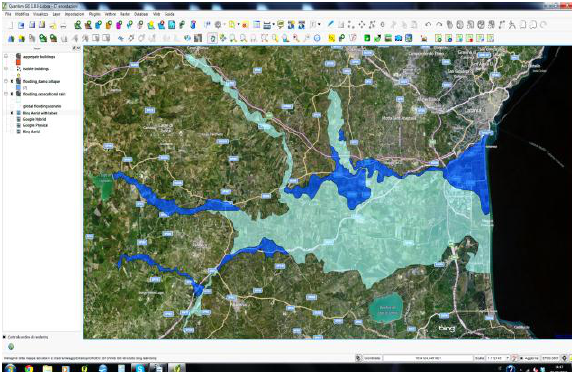
Figure 6. Simulated scenario of flooding in GIS environment to individuate the potential condition of risk for people and infrastructures